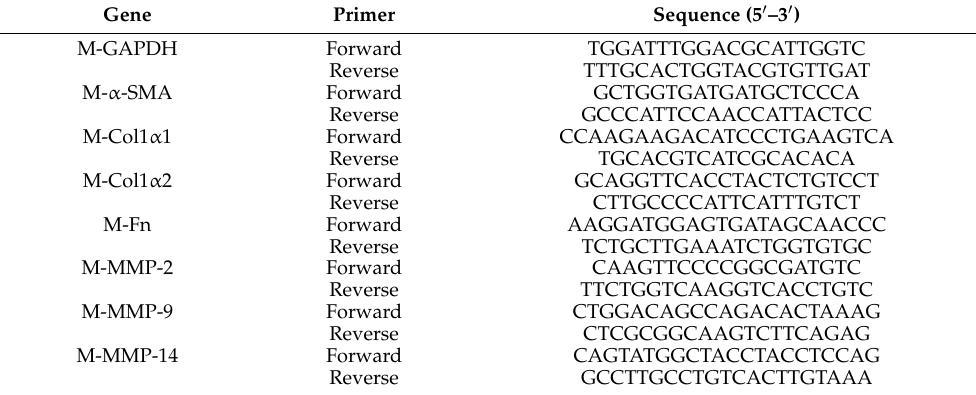
Table 1. Specific primers used in real-time PCR